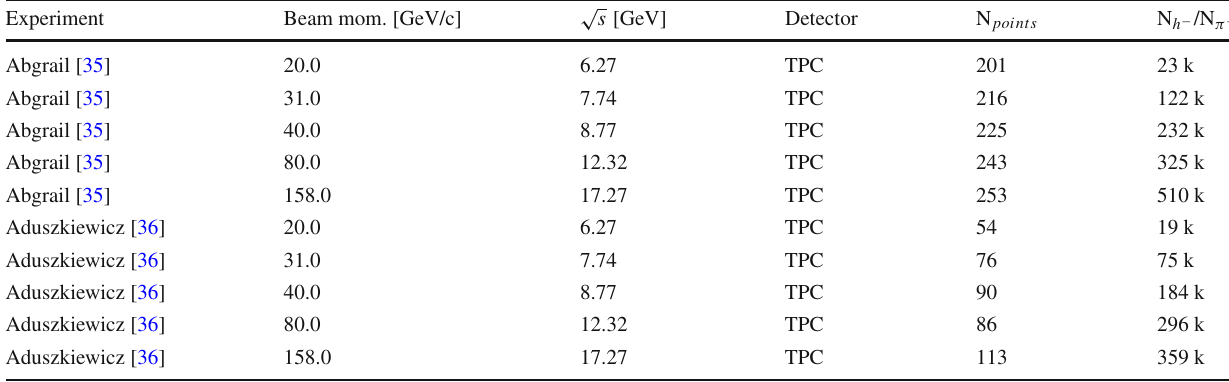
Table 3 The NA61 experiment Experiment